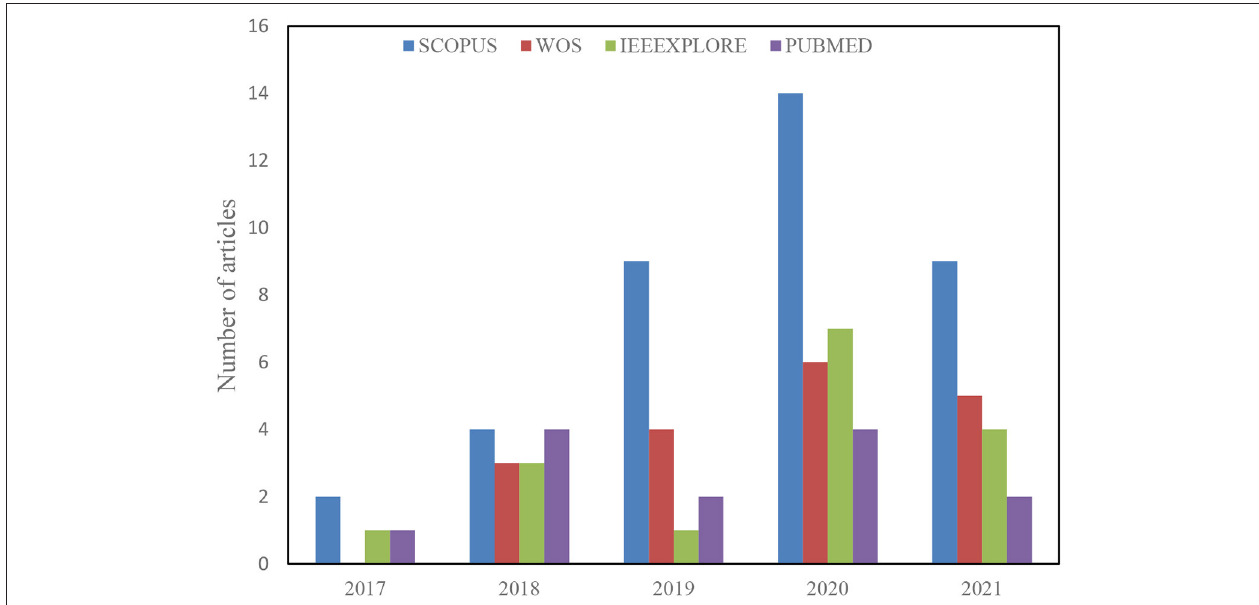
FIGURE 2 | Articles selection by database and